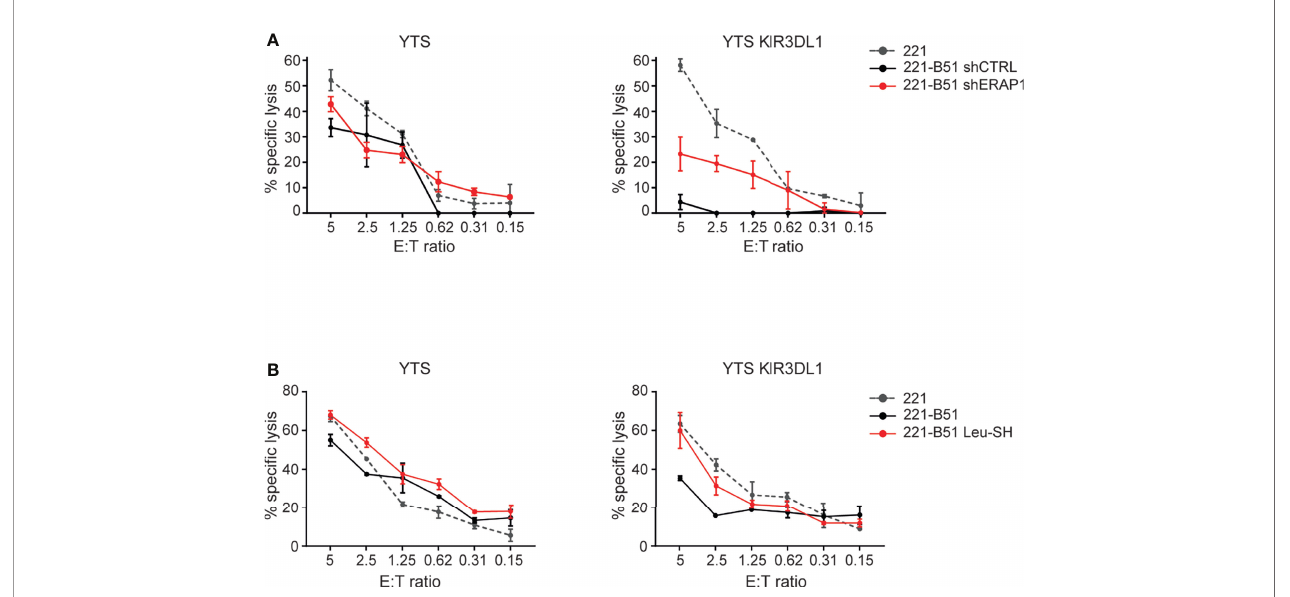
FIGURE 6 | Genetical and pharmacological inhibition of ERAP1 makes 221-B*51:01 cells more susceptible to lysis by NK cells expressing KIR3DL1*001. (A, B) 221 transfectant cells genetically (A) or pharmacologically (B) inhibited for ERAP1 were incubated with YTS or YTS-KIR3DL1*001 NK cells. A representative experiment of three independently performed is shown. Data represented mean ± SD of